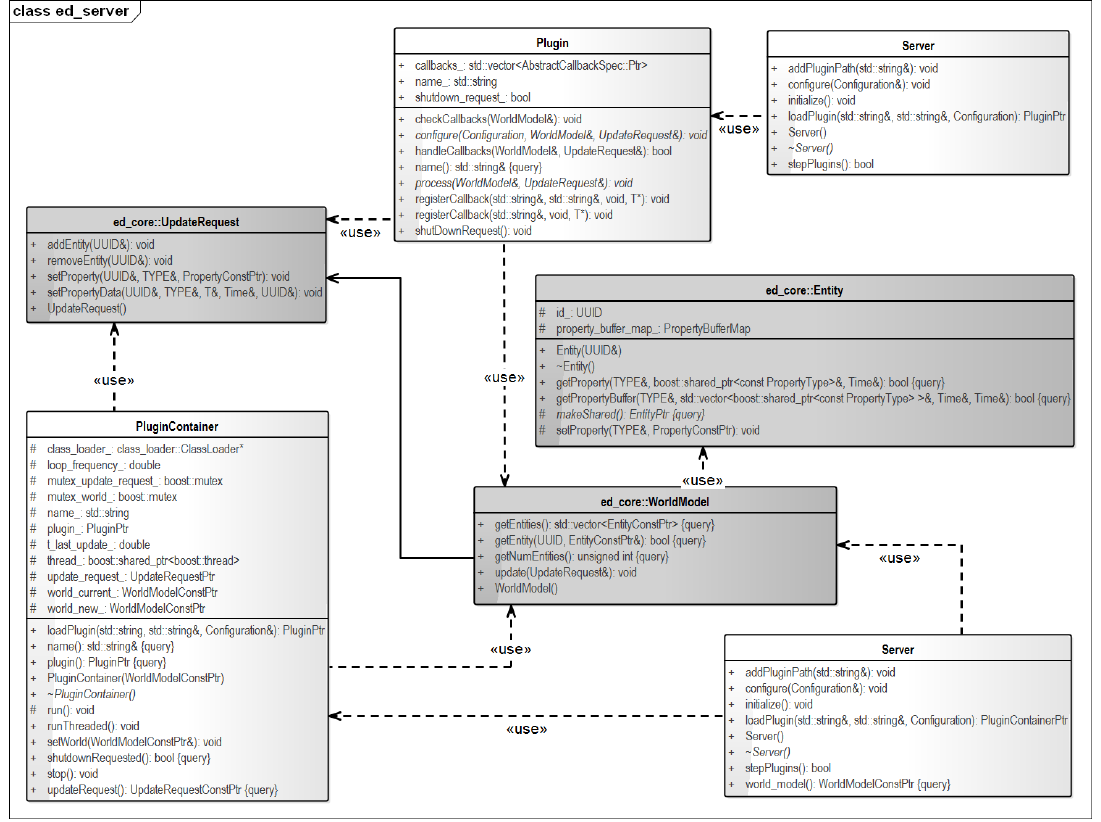
Figure 5. UML diagram of the world model